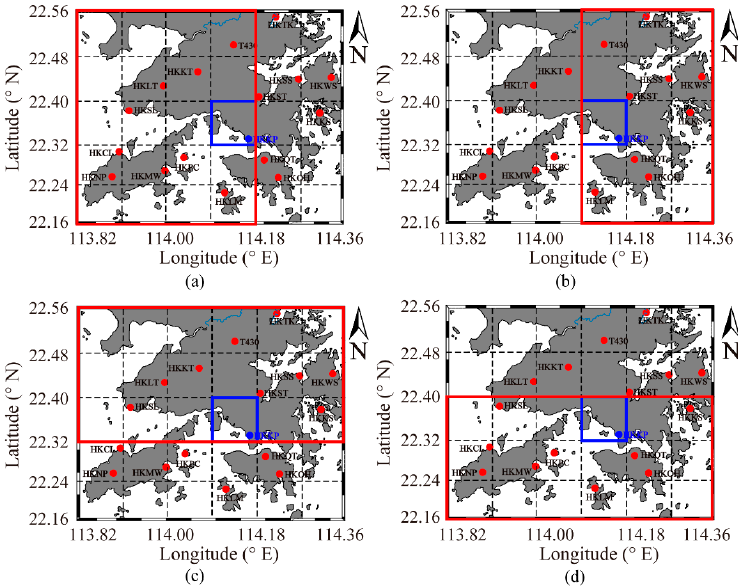
Figure 8. The tomographic region (red rectangles) for four schemes. (a) Scheme East; (b) Scheme West; (c) Scheme South; and (d) Scheme North. The blue square refers to the RS-voxels. Table 2. The range of the tomographic area and the number of voxels in the four schemes. Scheme Range